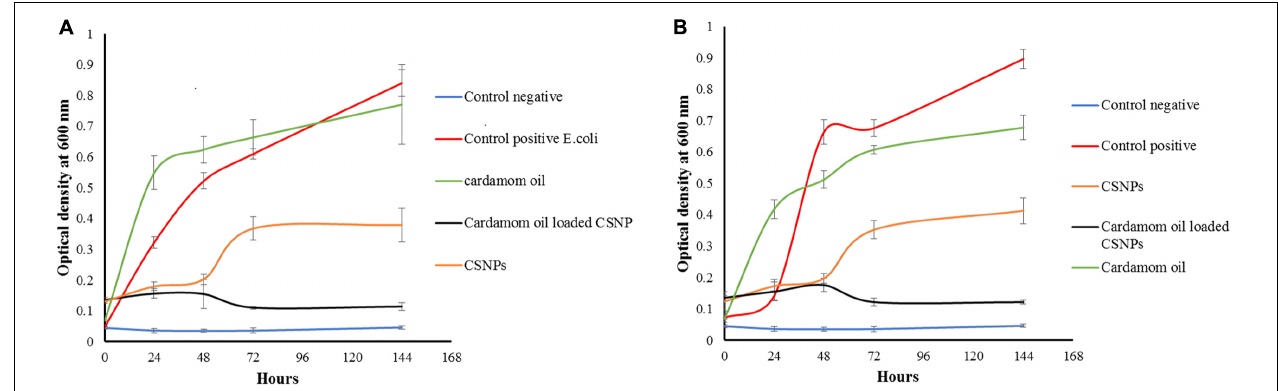
FIGURE 8 | Growth kinetics of (A) Escherichia coli (B) Methicillin-resistant Staphylococcus aureus. It can be observed that the cardamom oil-loaded CSNPs have completely eradicated both pathogens whereas, bare CSNPs initially controlled the pathogens for 2 days after that a rapid growth was observed.